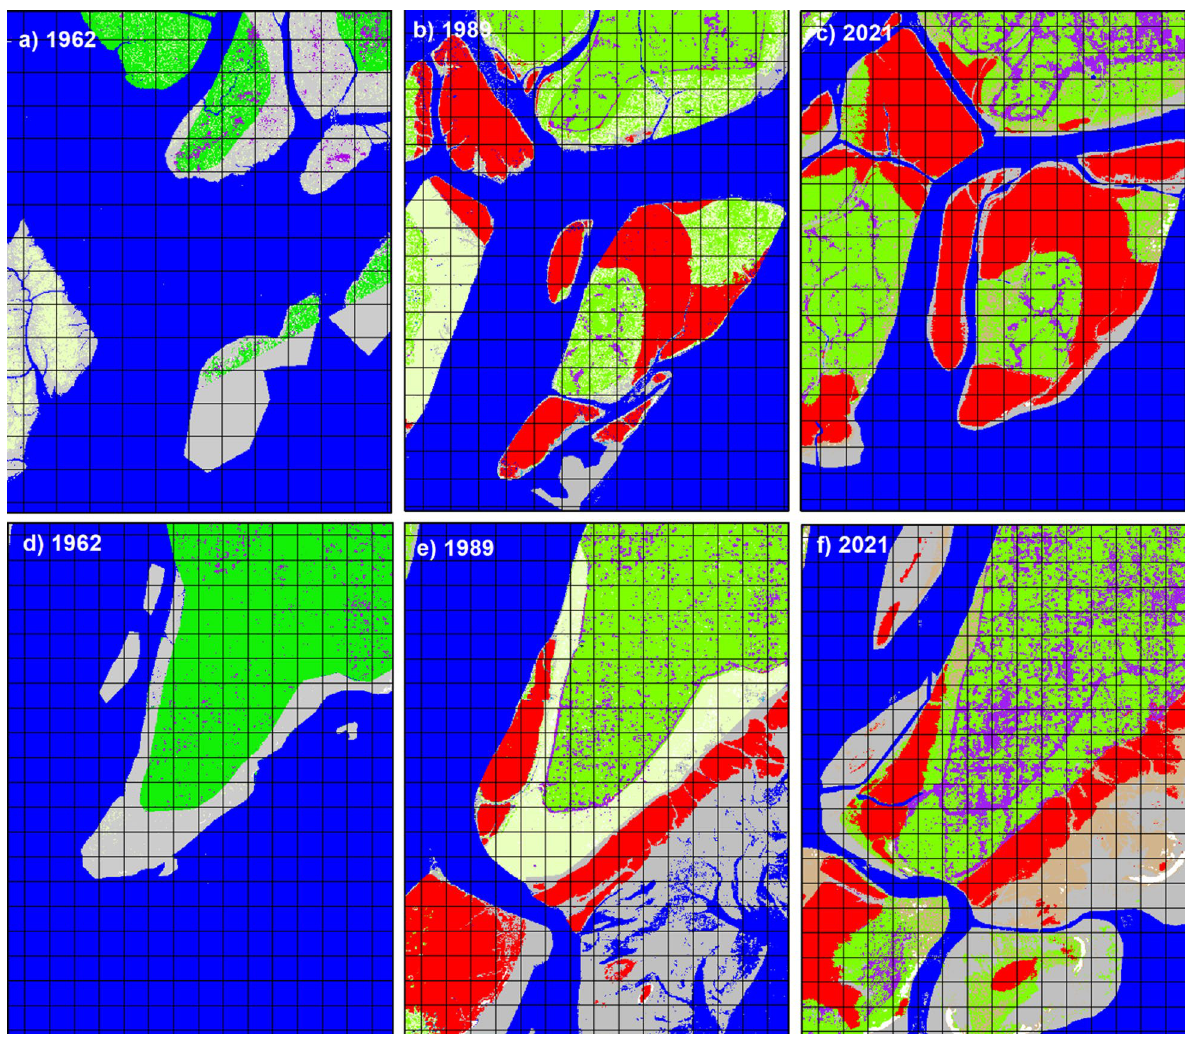
Fig. 7 A close-up view of the relationship between the NBS (mangrove afforestation) and agriculture, mudflats, homestead vegetation,